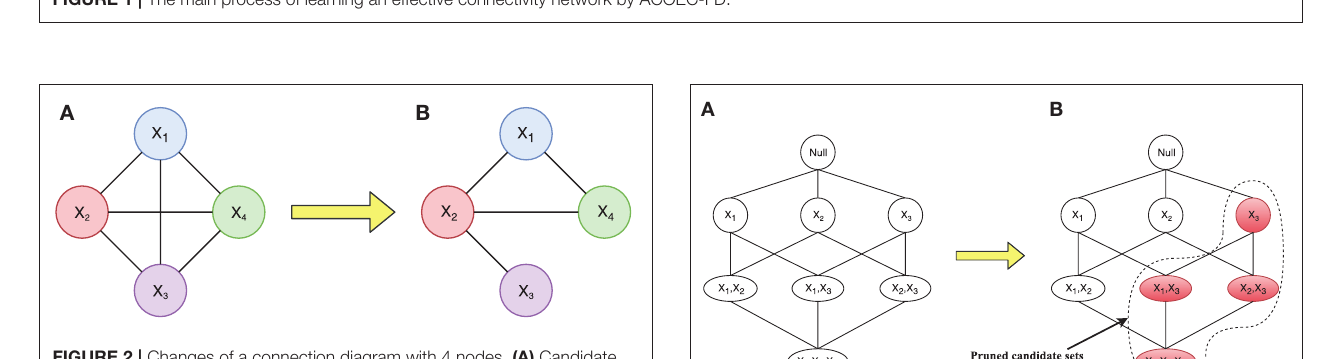
FIGURE 1 | The main process of learning an effective connectivity network by ACOEC-FD.